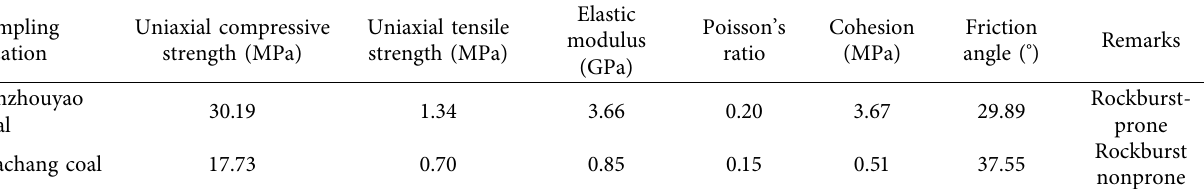
Table 1: Static mechanical properties of coal samples.